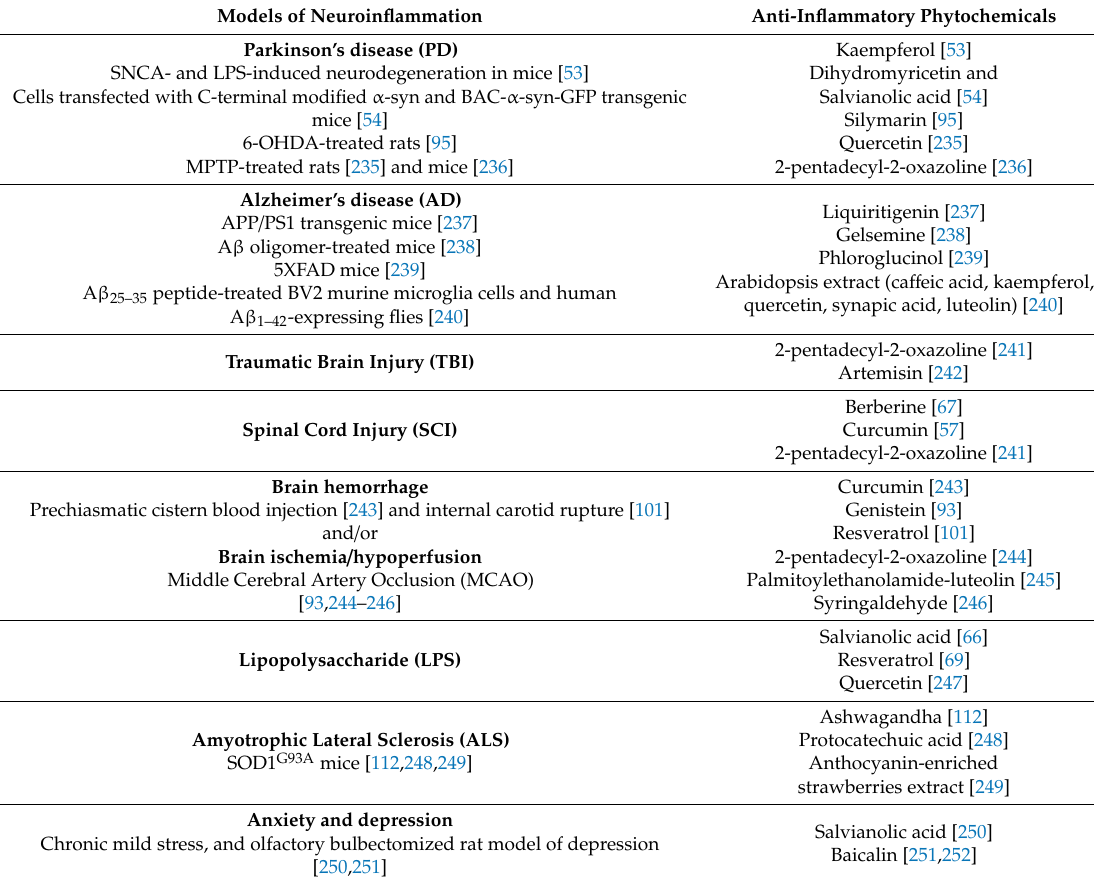
Table 1. Natural compounds providing beneficial e ff ects in models of neuroinflammation: a summary of recent